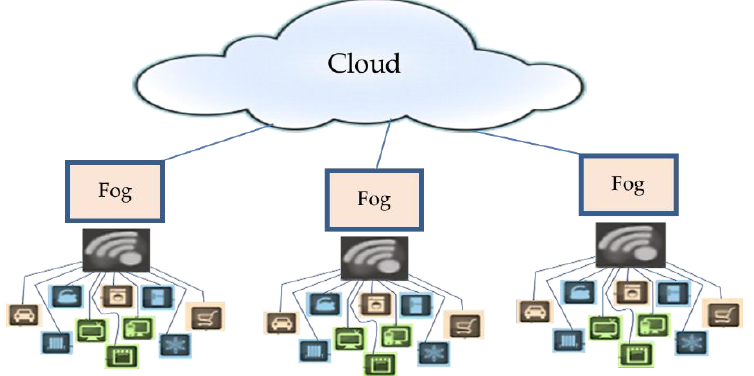
Figure 1. iIFCs Architecture (Flat fog